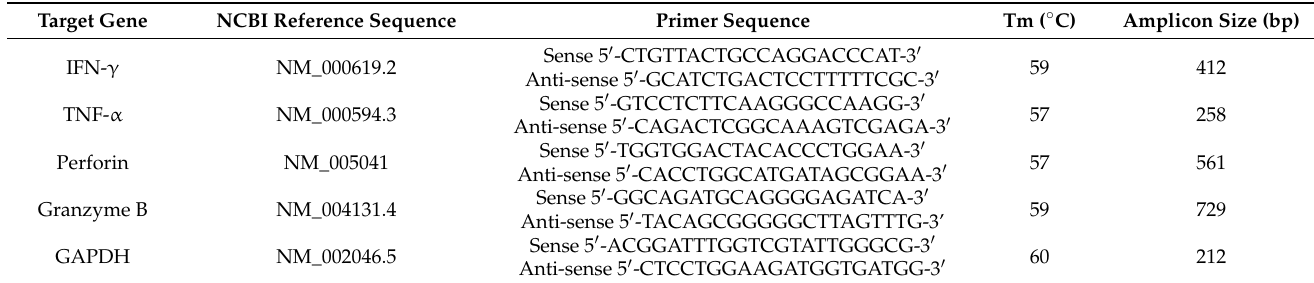
Table 1. PCR primer sequences for cytokine and cytotoxic granule